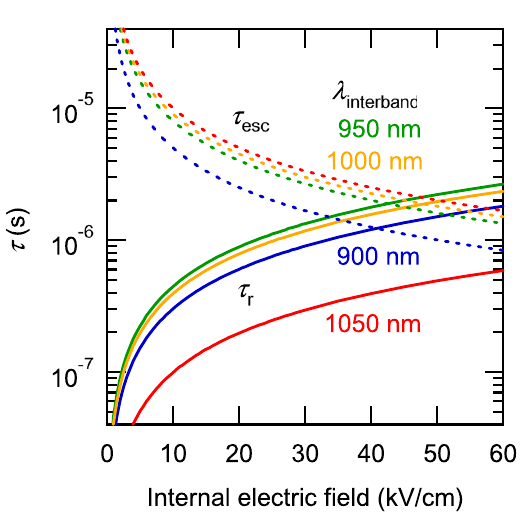
Figure 5. Internal electric field dependence of the evaluated time constants of τ r and τ esc at 900, 950, 1,000, and 1,050 nm as a function of the internal electric